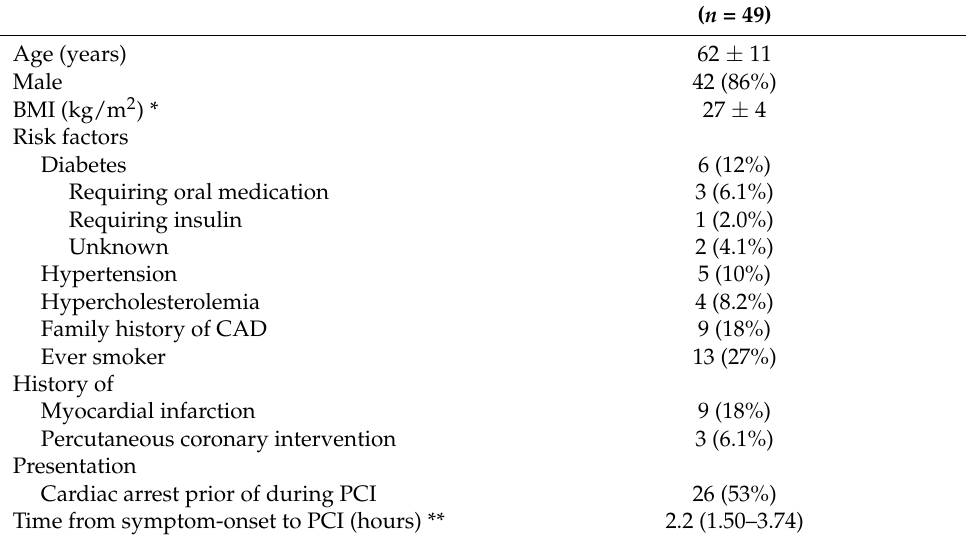
Table 1. Baseline clinical